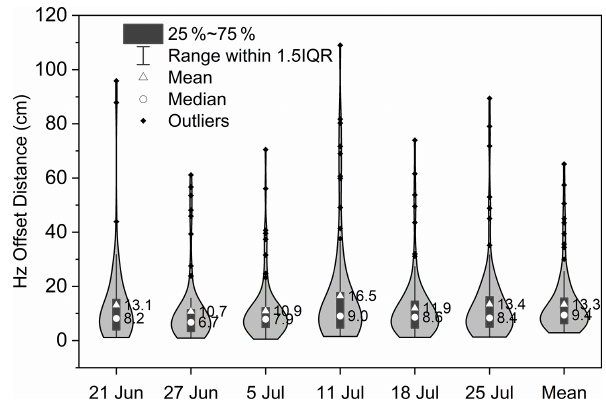
Figure 7. Horizontal (Hz) offset at check-point locations for each survey date’s RGB 5cm orthomosaic relative to the 14 August po- sition. The mean horizontal offset is shown in the right violin plot. Mean and median values labelled accordingly. The curve represents the kernel-smoothed frequency distribution of offsets.